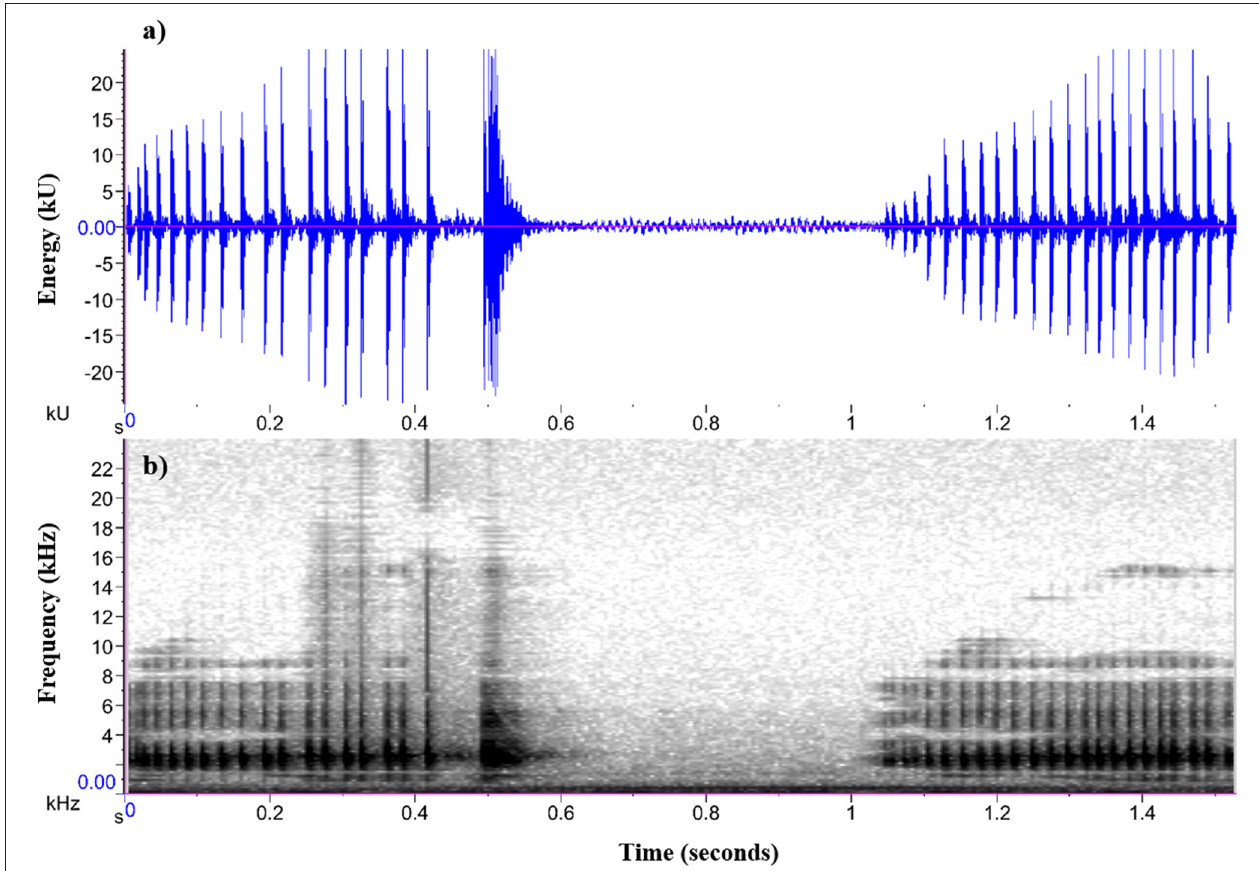
FIGURE 2 | (a) Oscillogram and (b) spectrogram of a male P. corroboree advertisement call (two-part and one-part call) used in call synthesis. call zone a female spent the maximum amount of time